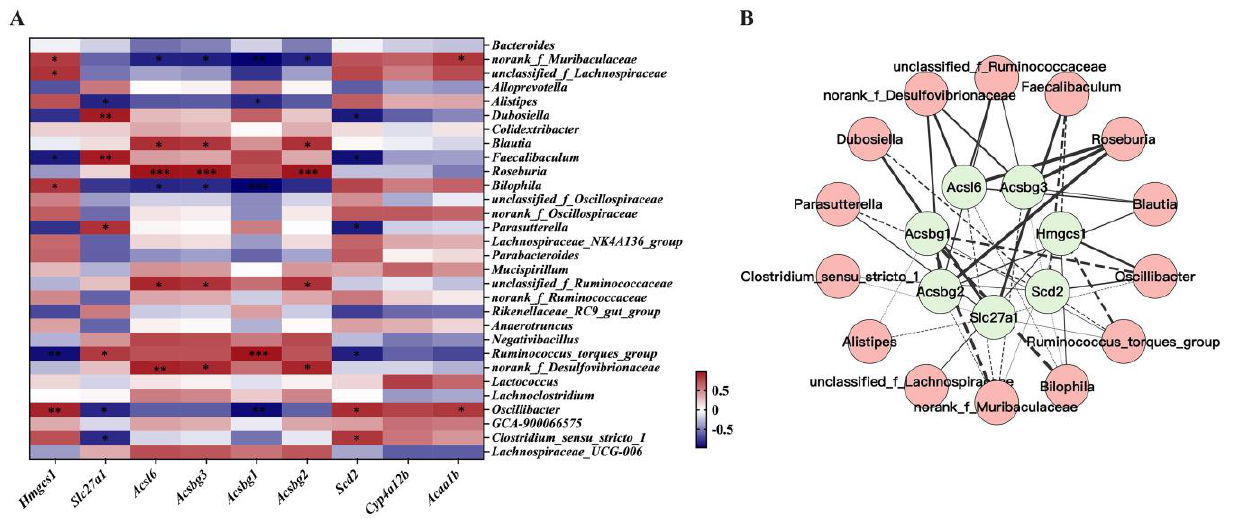
Figure 7. Correlation analysis of DEGs change and gut microbiota alterations. ( A ) Correlation heatmap between enriched DEGs determined by RNA-seq and gut microbiota at the genus level. The red color represents a positive correlation, while the blue color represents a negative correlation. The color depth is proportional to the degree of the correlation. * p < 0.05, ** p < 0.01, *** p < 0.001. ( B ) Network visualizing significant gene-microbe correlations. Green represents enriched DEGs and pink represents microorganisms. The solid lines represent a positive relationship, while the dashed lines represent a negative relationship. Edge thickness represents the strength of the correlation.